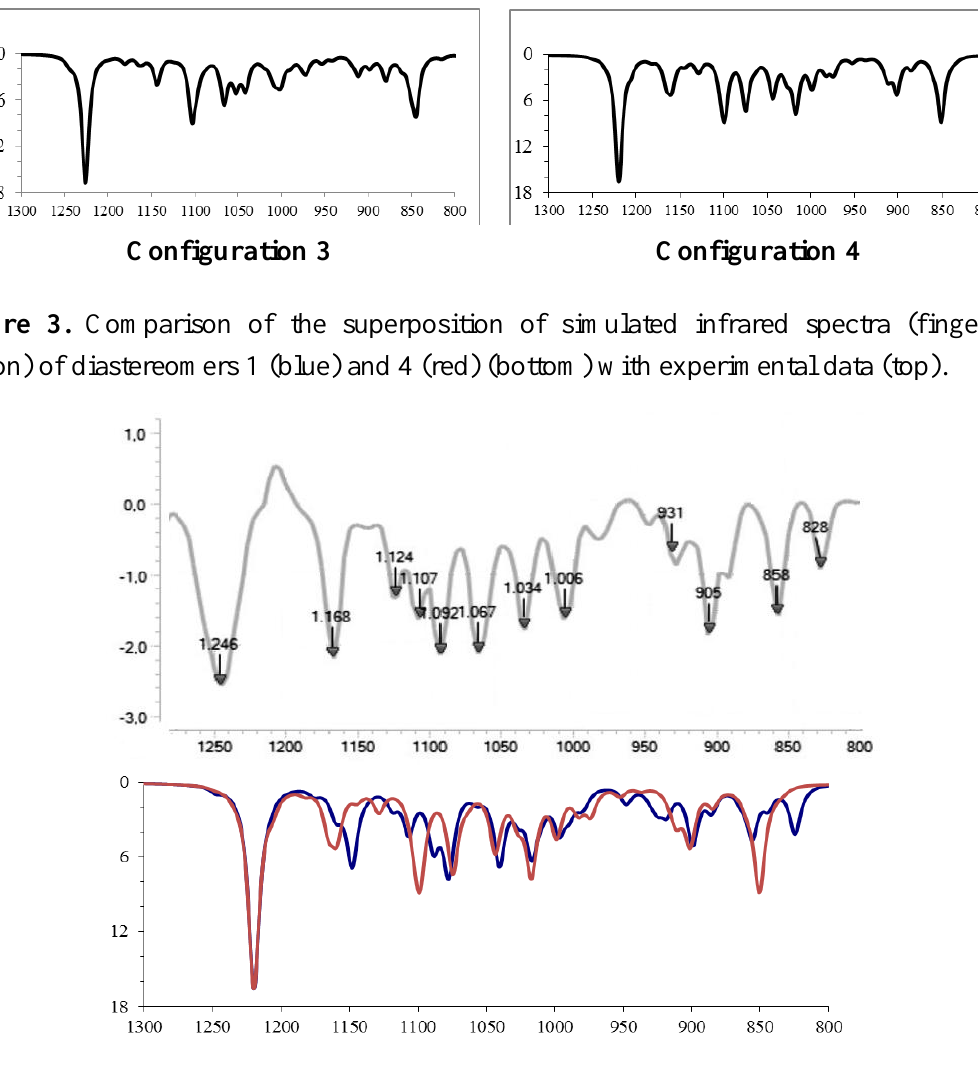
Table 3. Comparison of the fingerprint vibrational frequencies obtained theoretically (configuration 1) and experimentally for